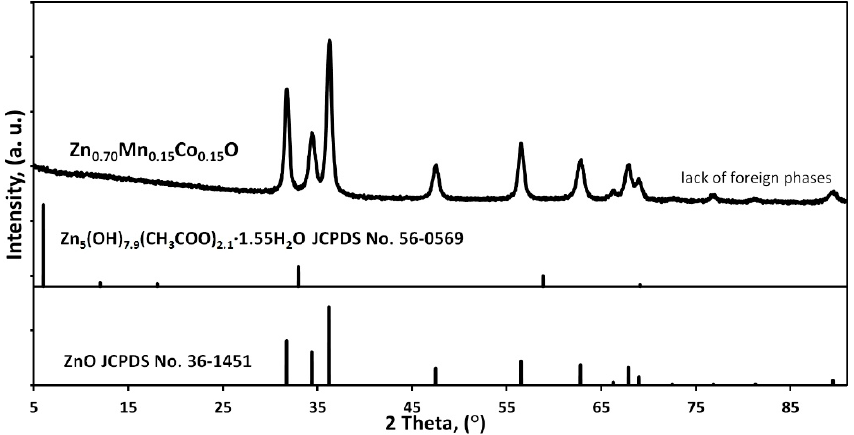
Figure 5. XRD diffraction pattern of the Zn 0.7 Co 0.15 Mn 0.15 O sample, and its comparison with the standard pattern of Zn 5 (OH) 7.9 (CH 3 COO) 2.1 ·1.55H 2 O (JCPDS No. 56-0569) and ZnO (JCPDS No. 36-1451).